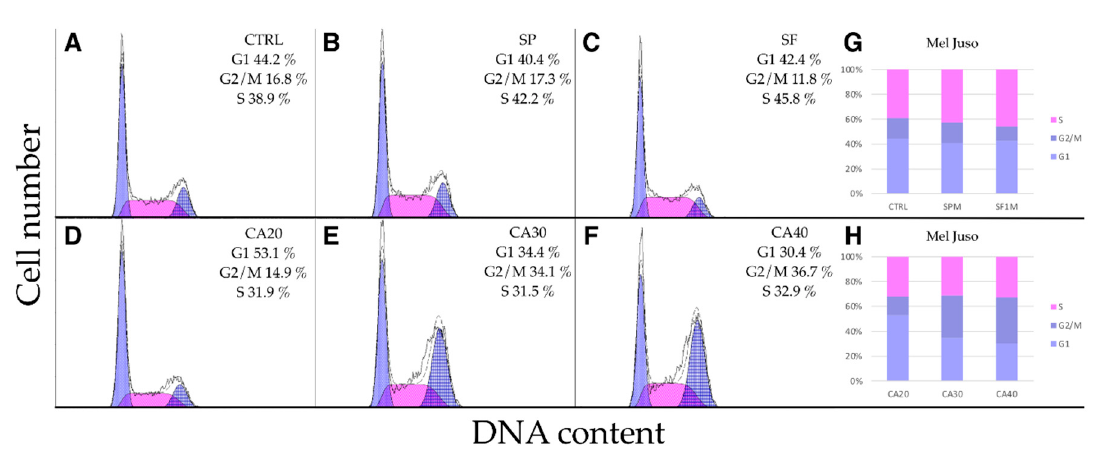
Figure 7. Cell cycle analysis of Mel JuSo cells. ( A ) Control DMSO treated cells. Cells treated 24 h with 100 µ g / mL of ( B ) SP, ( C ) SF methanolic extracts or ( D – F ) CA at concentrations of 20, 30 and 40 µ g / mL. ( G , H ) CA at concentrations 30 and 40 µ g / mL significantly increased the proportion of Mel JuSo cells in G2 / M phase.